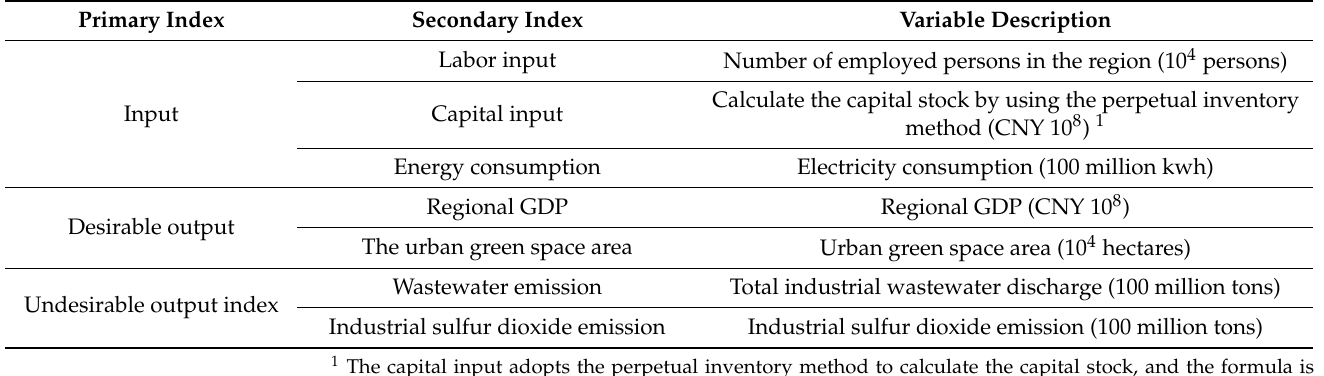
Table 1. GTFP measurement variables.